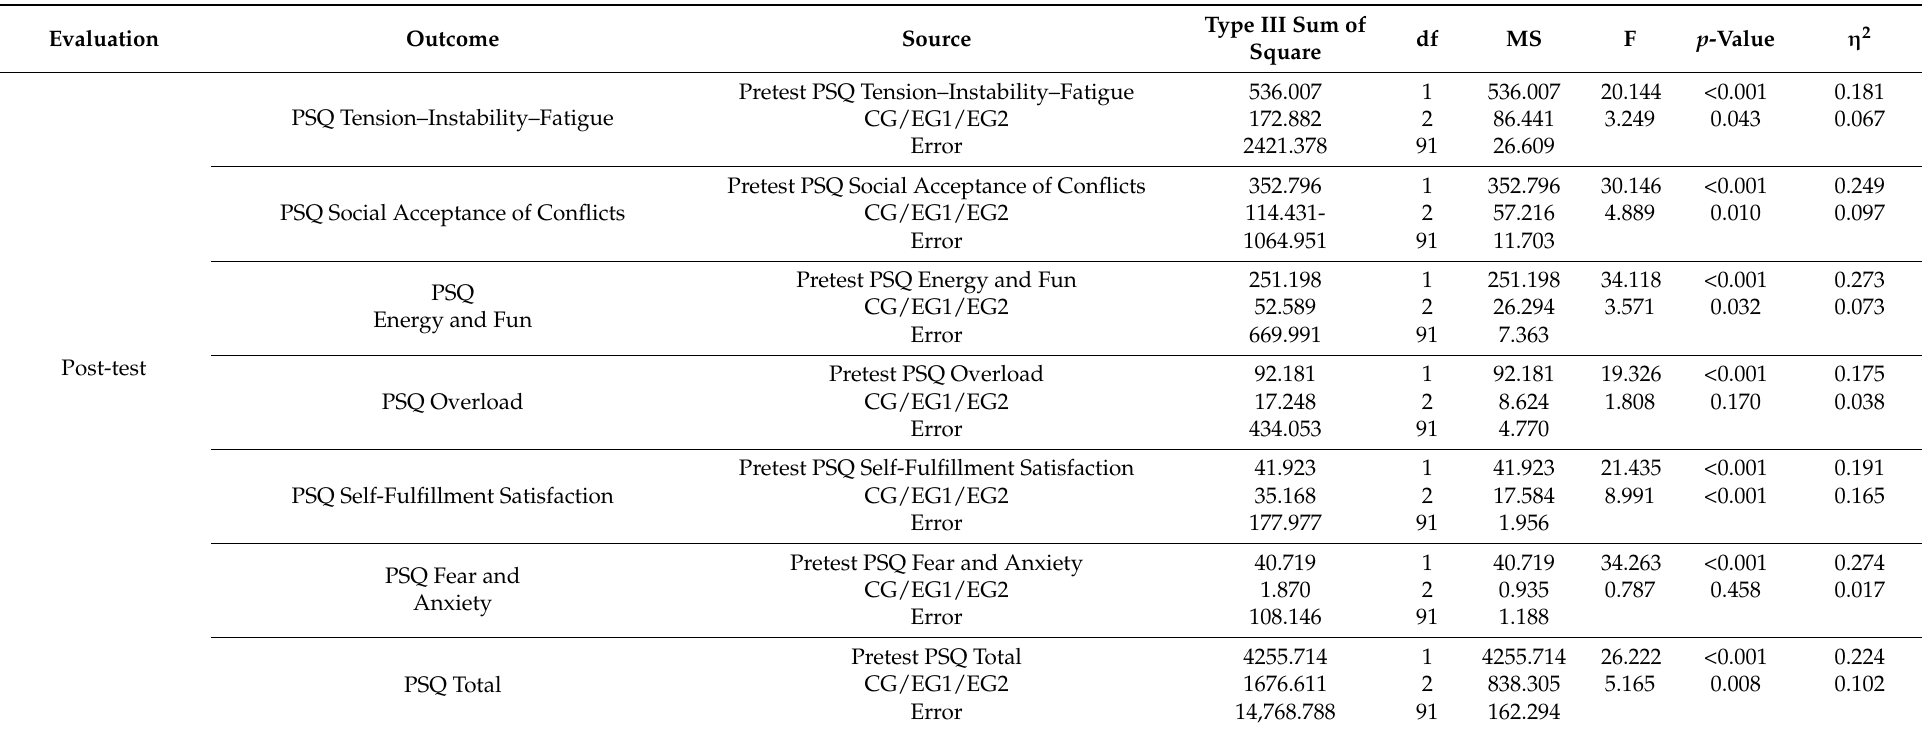
Table 4. Comparison between groups in post-test and follow-up scores, controlling pretest scores, using ANCOVA.